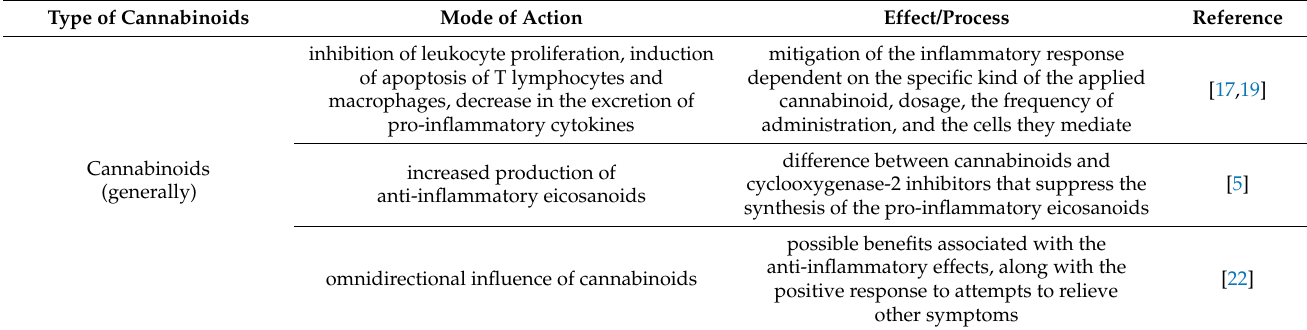
Table 1. Mechanisms of action of anti-inflammatory cannabinoids in preclinical studies. Type of Cannabinoids Mode of Action Effect/Process